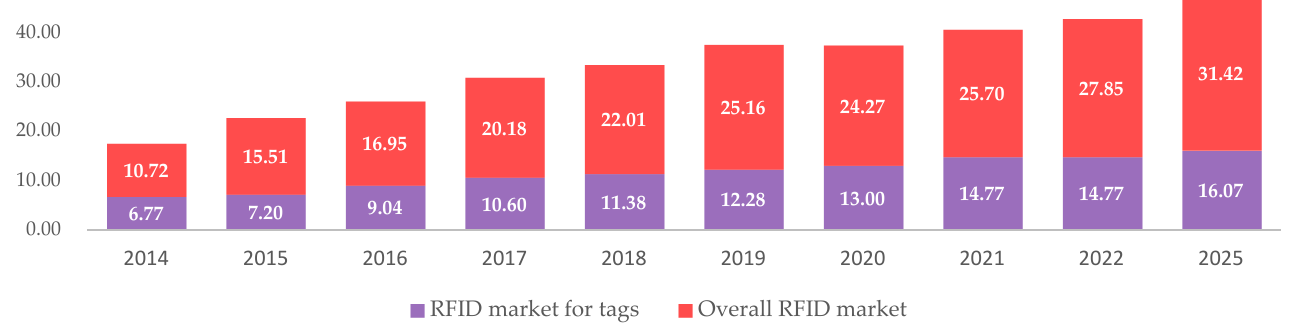
Figure 1. Worldwide Radio Frequency Identification (RFID) revenue [3].